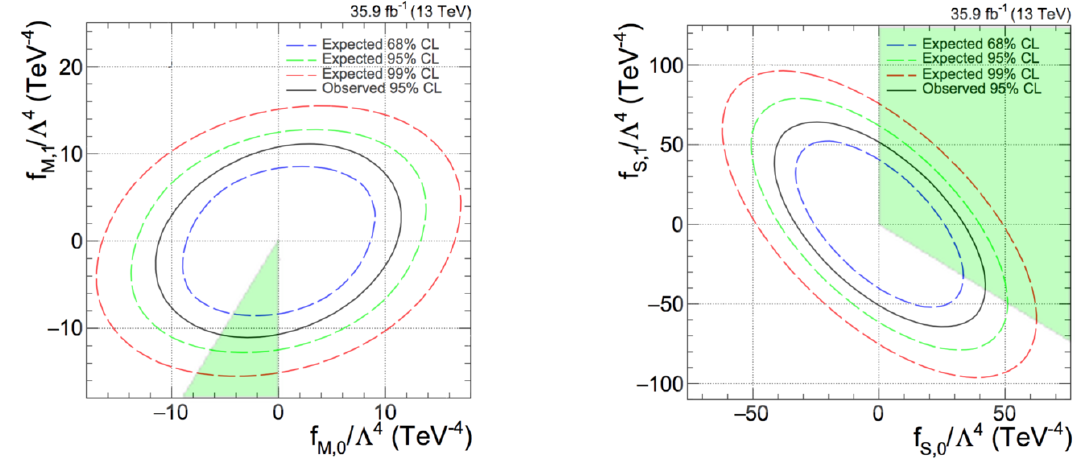
Figure 1 . Limits on pairs of QGC operator coe(cid:14)cients from CMS WZjj analysis [8]. Green shaded area represents positivity